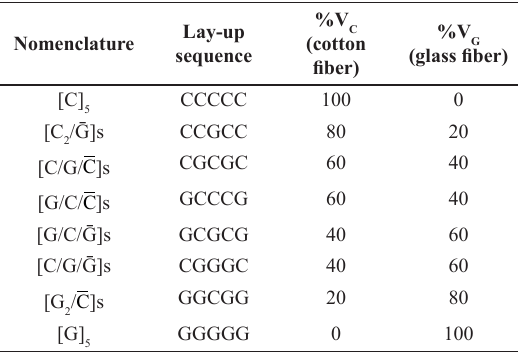
Table 1. Nomenclature used for the different lay-up sequences and the relative volume fraction of cotton and glass fiber (constant overall fiber content of 30 vol.%).